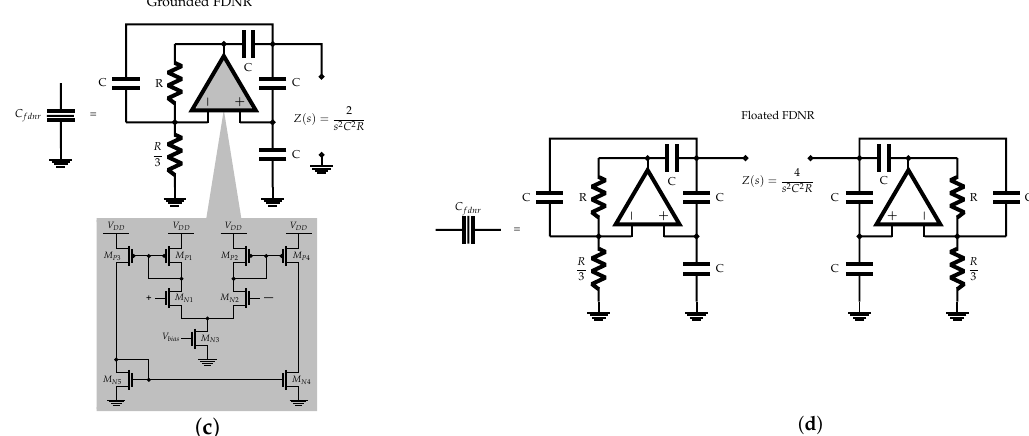
Figure 9. 7th order elliptic notch filter at 400 MHz: ( a ) LC network with double resistive termination; ( b ) FDNR conversion; ( c ) grounded version of active supercapacitor C fdnr ; ( d ) floated version of active supercapacitor C fdnr